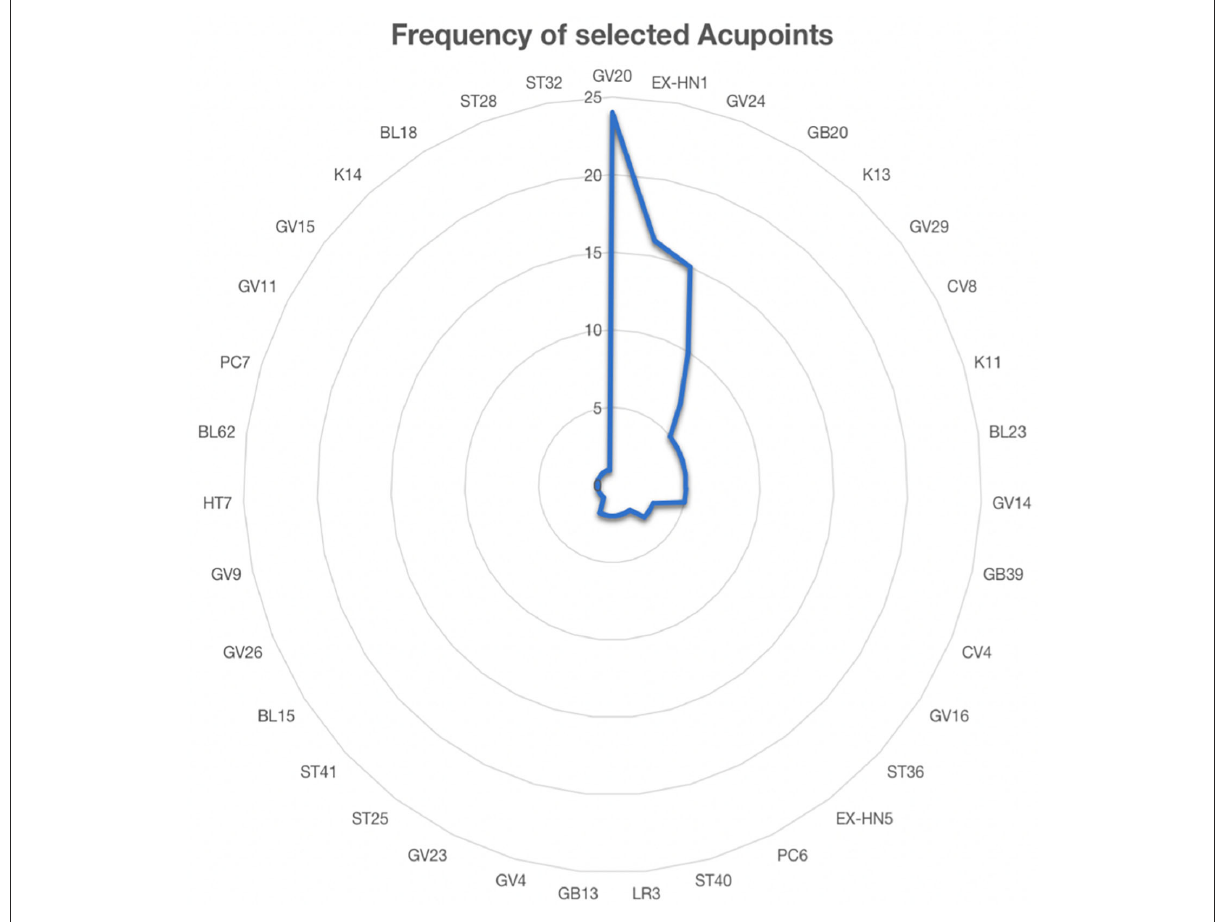
FIGURE8 The frequency of selected acupoints for